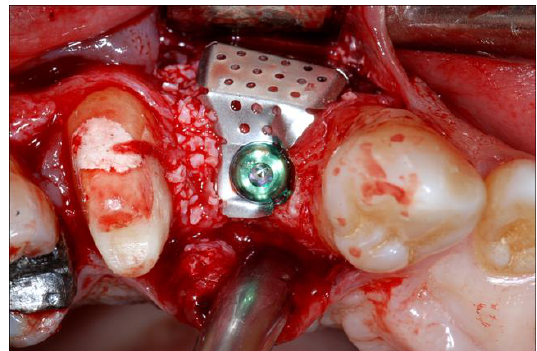
Figure 4. Placement of the titanium mesh, stabilized to the implant with a cover screw fixed to the flat abutment.